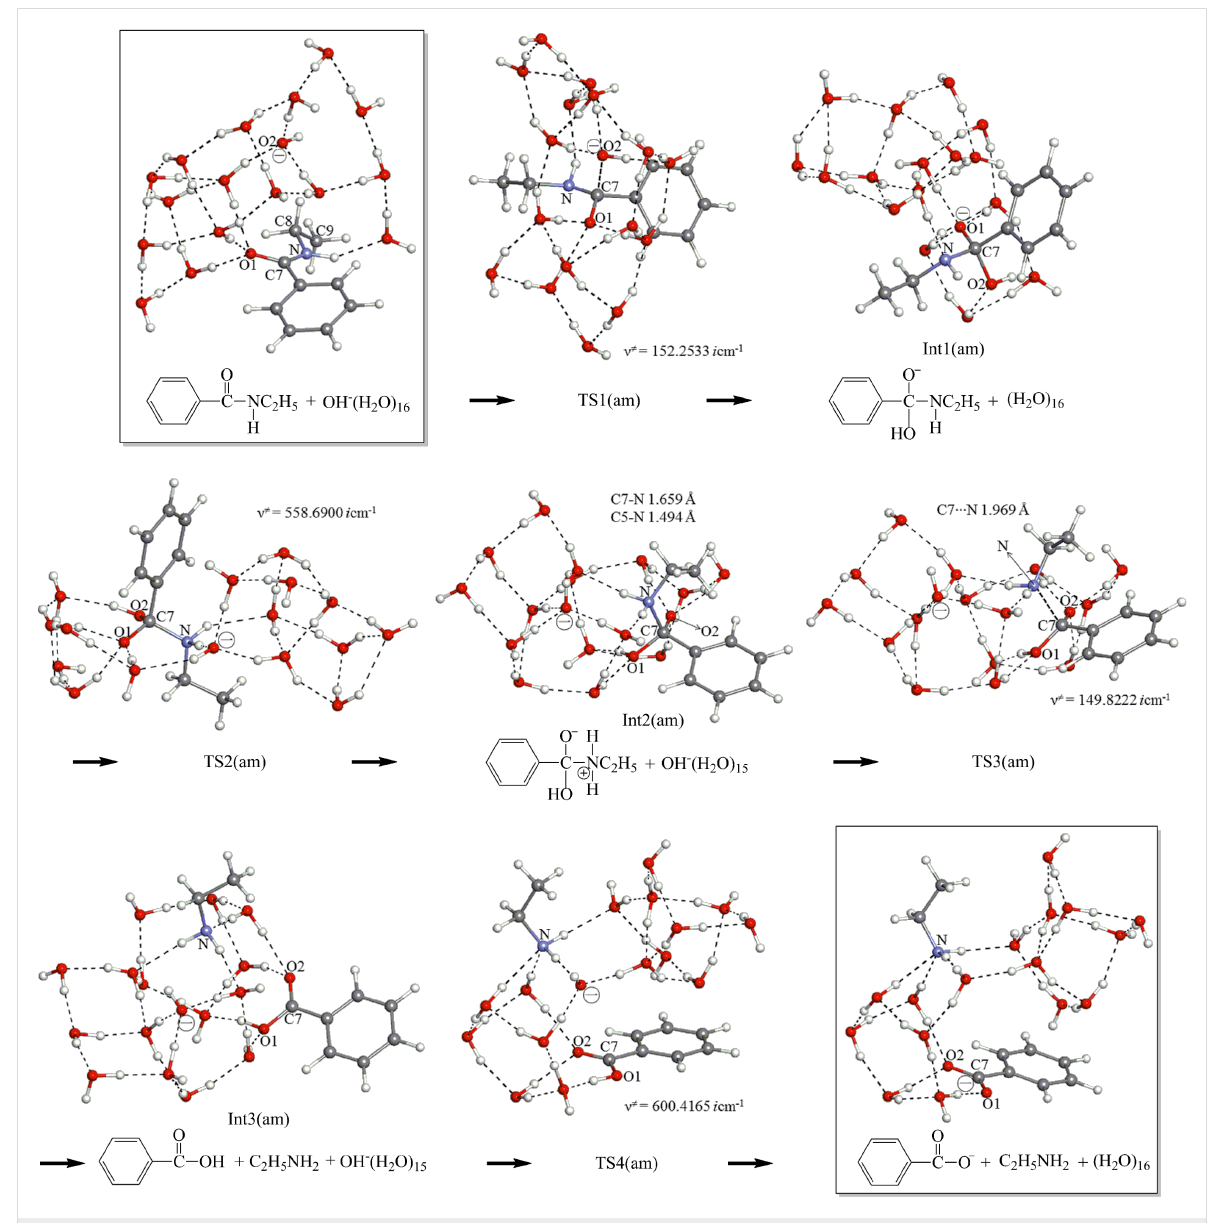
Figure 5: Reaction paths of the amide n = 16 hydrolysis. XYZ coordinates in VII.d (Supporting Information File 1).